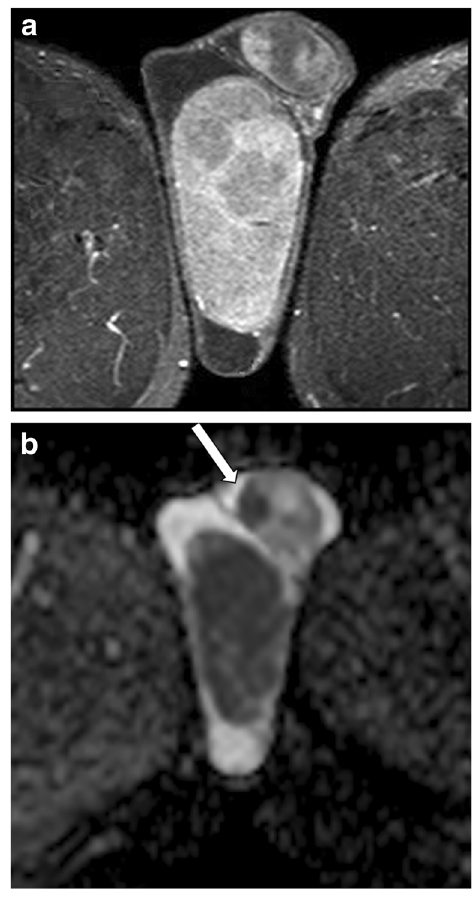
Fig. 7 a - b MRI in a case of bilateral seminoma. a Post-contrast T1- weighted SPIR TSE sequence, axial view and b ADC map, demonstrating a large right testicular mass and a smaller left intratesticular one (arrow), with heterogeneous contrast enhancement and restricted